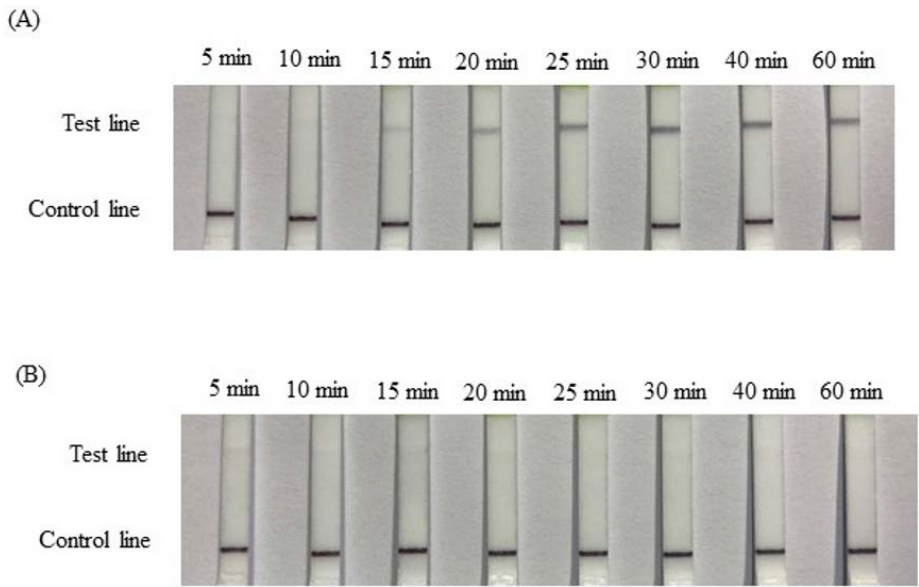
Figure 3. Optimization of RPA-LFD at different reaction times. ( A ) Reactions containing 0.1 ng/μL of genomic DNA from a female pigeon performed at 37 °C for different reaction times. ( B ) Reactions containing 0.1 ng/μL of genomic DNA from a male pigeon performed at 37 °C for different reaction times.